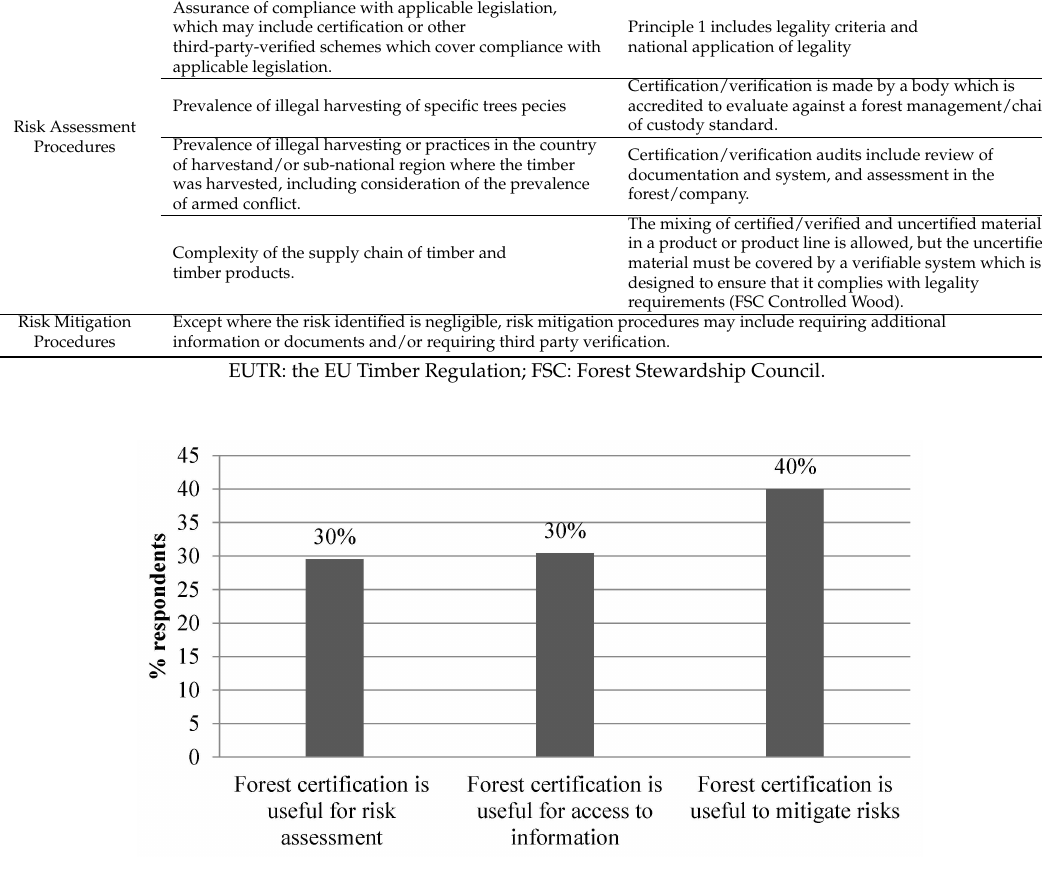
Figure 3. Role of forest certification in fulfilling the EUTR